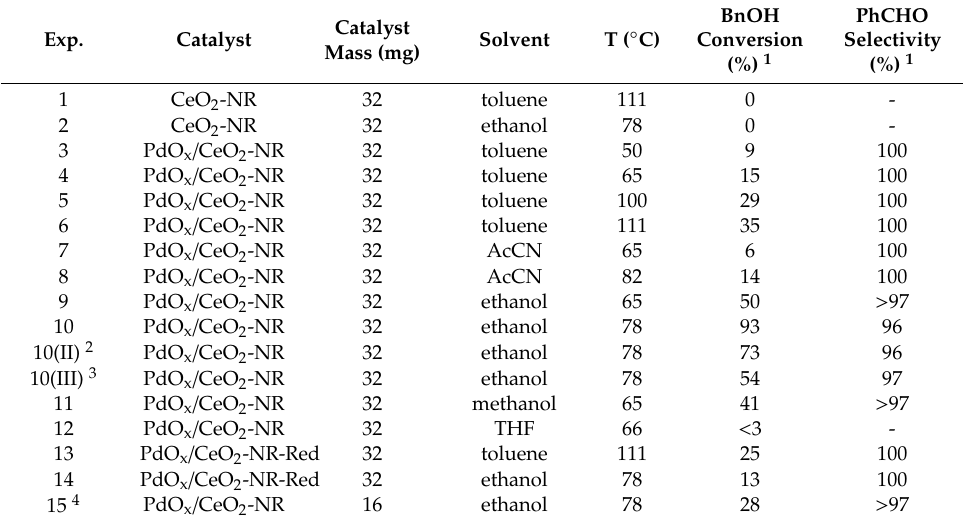
Table 3. Aerobic oxidation of BnOH to PhCHO: reaction parameters and results.